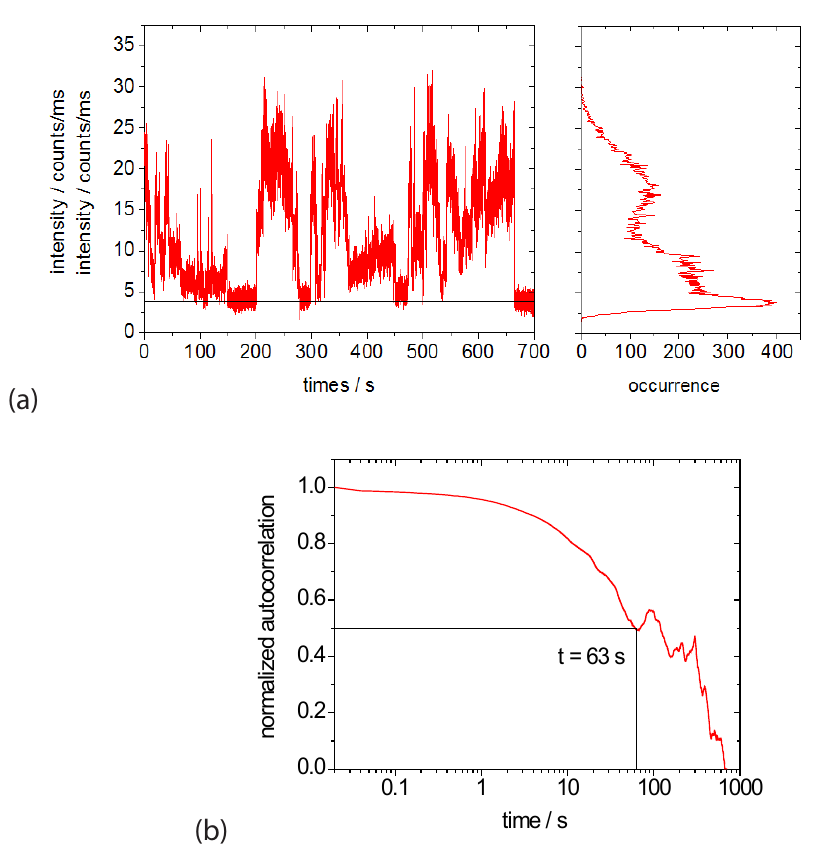
Figure 2. An example of a single molecule of 1 measured at 33°C ( T + 5°C) (a) fluorescence trace with fluorescence intensity histogram (the g black horizontal line shows the background level) (b) autocorrelation curve of the fluorescence trajectory with indicated time at which the autocorrelation function drops to its half